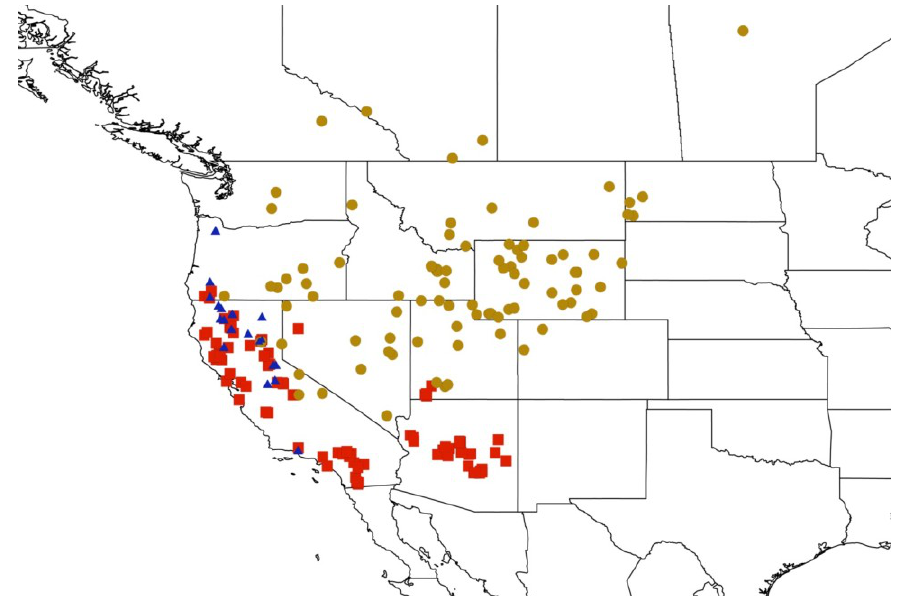
Figure 56. Distribution of Okanagana luteobasalis (gold circles), O. rubrovenosa (red squares) and O. vandykei (blue